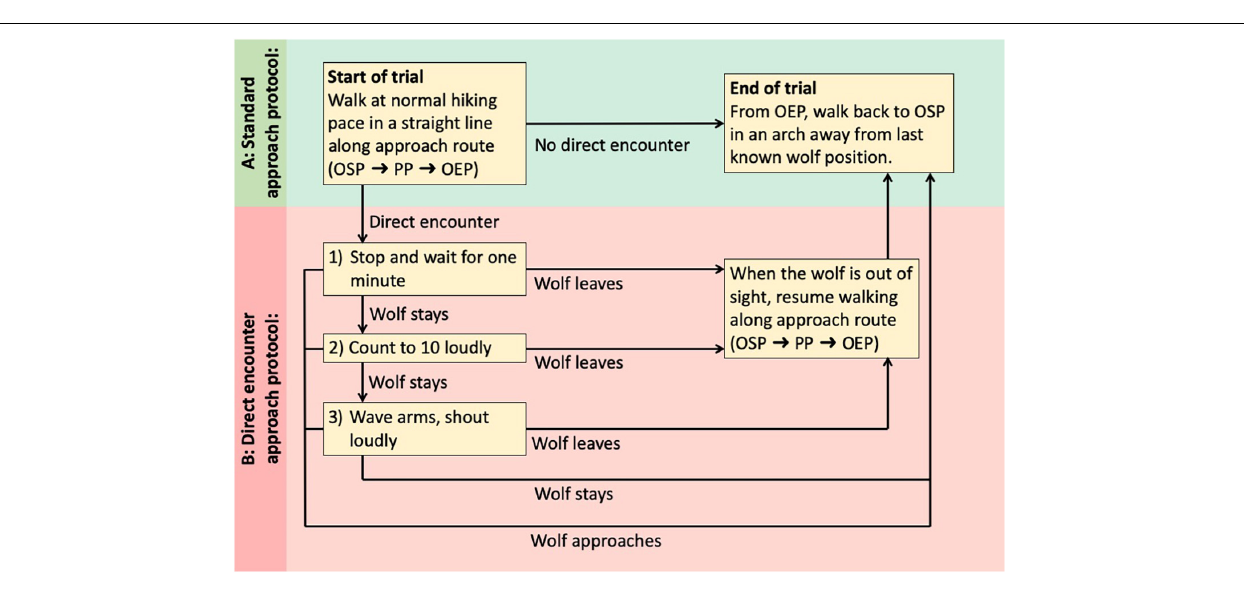
FIGURE 2 | Sequence of a standardized experimental human approach trial on wild wolves. Observer will switch from standard protocol (A) to direct encounter protocol (B) if all the following criteria for direct encounter are met: (1) visual observation of a wolf ahead of the observer when observer is facing OEP, (2) observer would have noticed the wolf in a non-trial situation, (3) wolf is aware of observer, and (4) wolf does not leave immediately. OSP, observer start position; PP, passing position; OEP, observer end position (defined in Figure 1